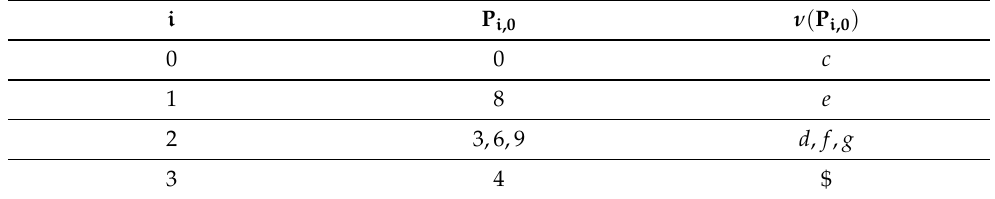
Table 1. The sets of states P i ,0 and the valid lookahead sets ν p P i ,0 q for the specification Ξ in (2). i P i